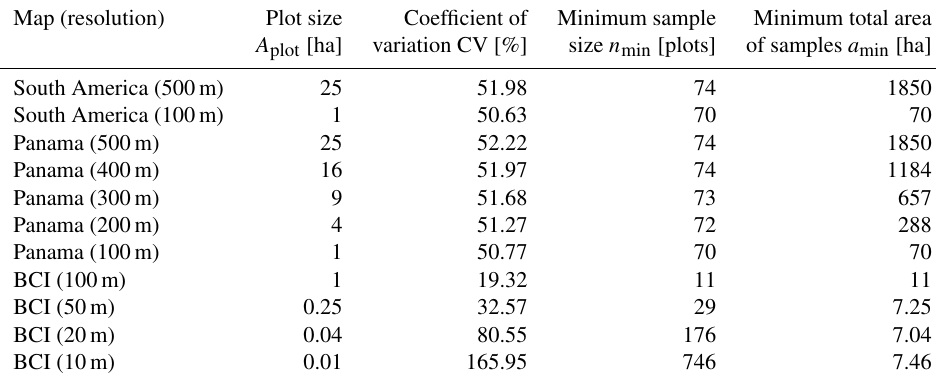
Figure 3. Analysis of different random sampling strategies for the Barro Colorado Island forest (BCI, 50ha). (a) Analytical results showing the number of plots and probability ( P n ) that the mean biomass of those plots reflects the mean biomass of the forest (for details, see Methods). We consider strategies using 0.01–1ha plots (plot size, represented by line colors). The upper boundary (grey) marks sample sizes with at least a 90% chance of meeting the mean biomass of the original biomass map. (b) Necessary number of plots, n min , to estimate the biomass reliably (minimum sample size from samples with P n ≥ 90%). Shapes above the bars represent the necessary sampling area, a min = A plot × n min . Table 1. Analyzed forest biomass maps and the corresponding minimum sample size. The forest biomass maps for South America (11000000km 2 ; Baccini et al., 2012; Dinerstein et al., 2017), Panama (50000km 2 ; Asner et al., 2013), and Barro Colorado Island (50ha; Condit et al., 2012) and their random sampling performance are shown. Different resolutions of the maps led to different results. The min- imum sample size refers to the necessary number of plots to accurately estimate the observed mean biomass of the forest (the mean of the samples does not deviate more than 10% from the observed mean biomass with a probability of at least 90%). The last column shows the necessary sampling area, a min = A plot × n min . Map (resolution) Plot size Coefficient of Minimum sample Minimum total